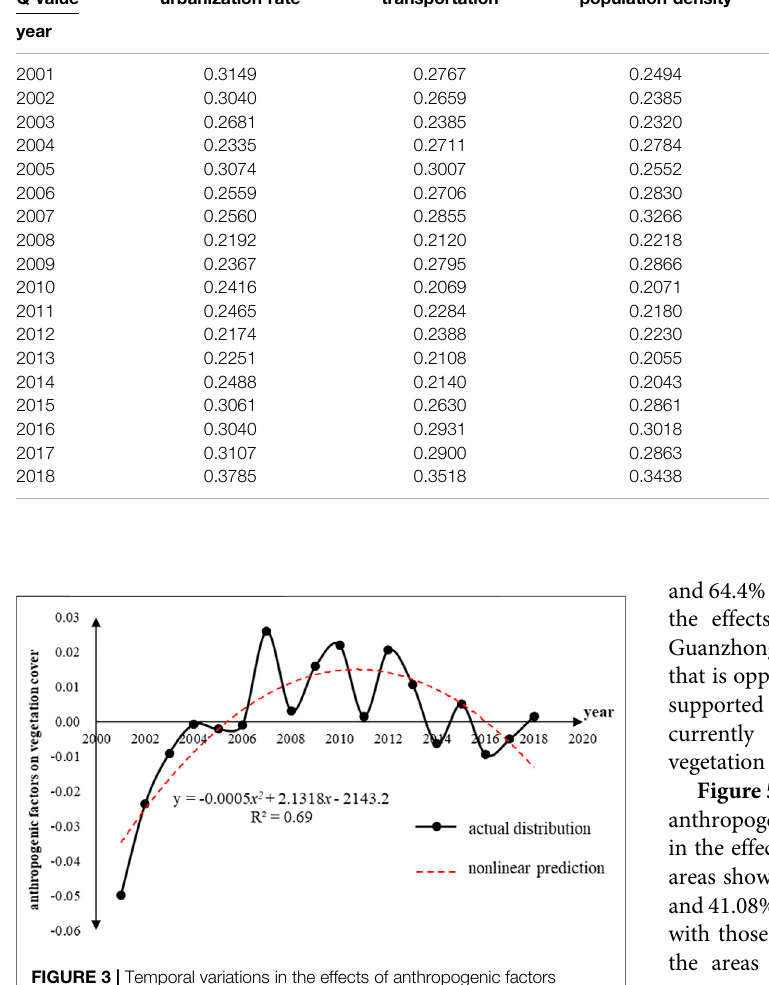
Frontiers in Earth Science |